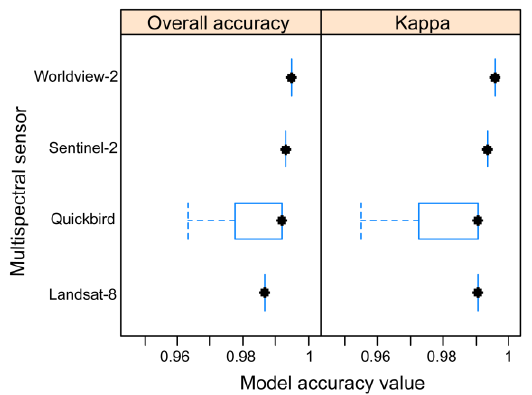
Figure 4. Models performance for separating the five ‘push- pull’ components as evaluated by overall accuracy and Kappa statistics, using all the resampled band configurations of four multispectral